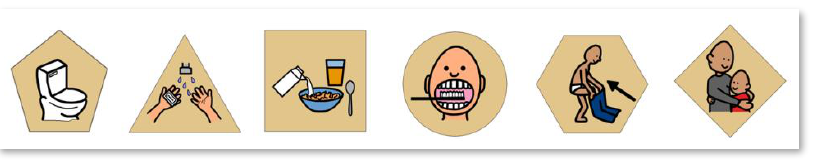
Figure 11. Square wooden board.